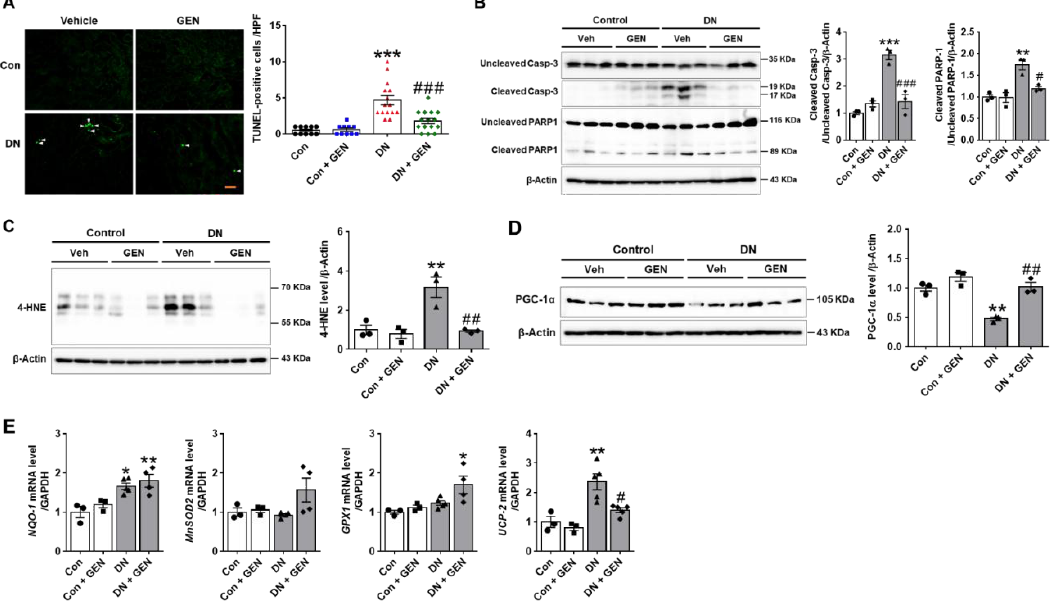
Figure 3. Geniposide decreases renal apoptosis and oxidative stress in DN. ( A ) Representative images of TUNEL staining processed in the kidney sections to determine DN-induced renal apoptosis. The number of TUNEL-positive cells/high power field (HPF) was counted to present the severity of apoptosis ( n = 3). ( B ) The extent of caspase-3 and PARP-1 cleavage was determined in the kidney tissue lysates by western blot analysis and the relative quantification was shown ( n = 3). ( C ) Oxidative stress was assessed by measuring 4-HNE, a marker of lipid peroxidation by western blot analysis and the relative quantification was shown ( n = 3). ( D ) The protein expression levels of PGC-1α and β-actin, as a loading control, were determined by western blot analysis in kidney tissue lysates. Quantitative analysis was shown ( n = 3). ( E ) The Relative mRNA levels of NQO-1, MnSOD2, GPX1 and UCP2 were determined by real-time PCR analysis. Relative mRNA expression was normalized to that of GAPDH ( n = 3–5). Data are presented as the mean ± SEM. One-way ANOVA was used for statistical analysis followed by Bonferroni’s multiple comparisons. * p < 0.05, ** p < 0.01, *** p < 0.001 vs. control mice; and # p < 0.05, ## p < 0.01, ### p < 0.001 vs. DN mice. Scale bar, 50 µm.